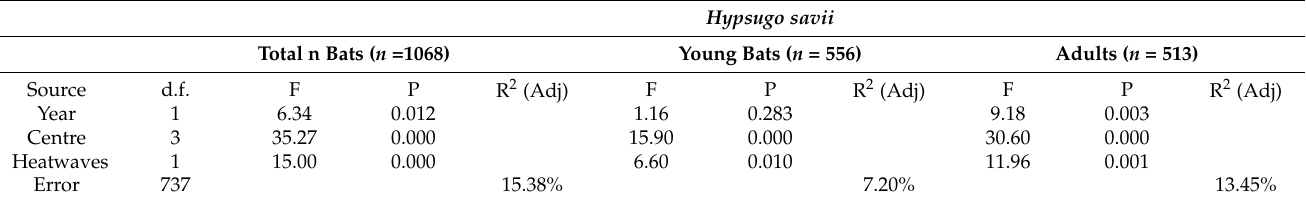
Table 3. Results of a GLM ANCOVA on Hypsugo savii admitted at four Italian rehabilitation centres in 2007–2021. Temperature = weekly mean of maximum temperatures recorded.